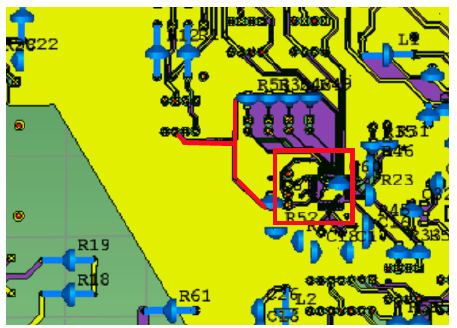
Figure 17. Local model of merging unit.